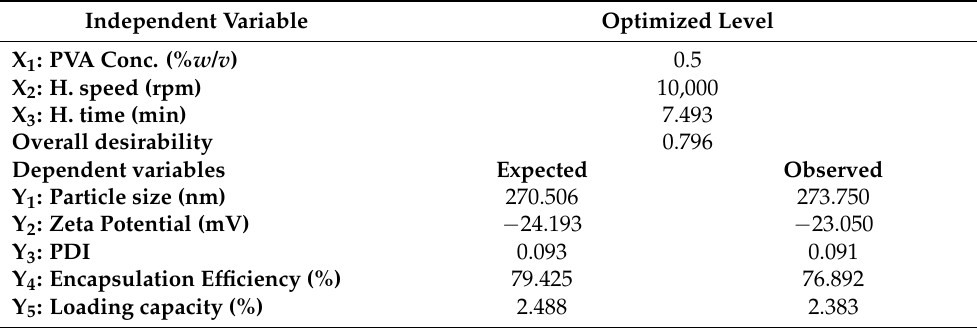
Table 3. The optimized PLGA-Cf NPs observed and predicted response